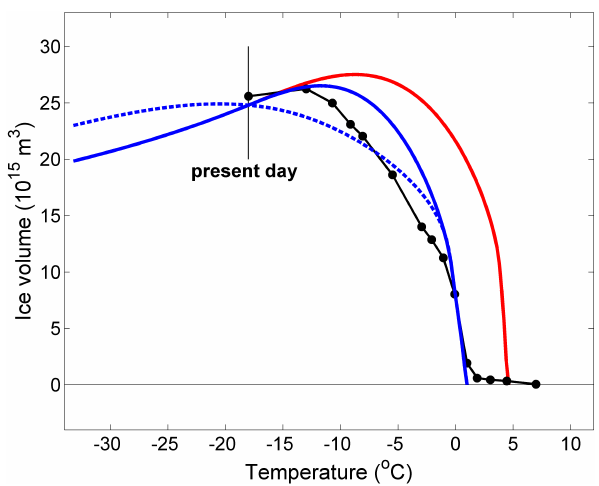
Figure 2. Sensitivity of equilibrium solutions of DAIS model ice volume to Antarctic temperature reduced to sea level. Shown are solutions for the original (but corrected) Oerlemans (2005) model (case 1, Table 2) for present-day sea level (SL) and values for ν (Table 1) of 0.006 and 0.012m − 0 . 5 yr − 0 . 5 (red and blue solid line, respectively) and for a preferred model configuration (case 4, Ta- ble 2) for present-day SL and ocean subsurface temperature (blue dashed line). The black dots are comparable 3-D thermomechanical model solutions (Huybrechts,